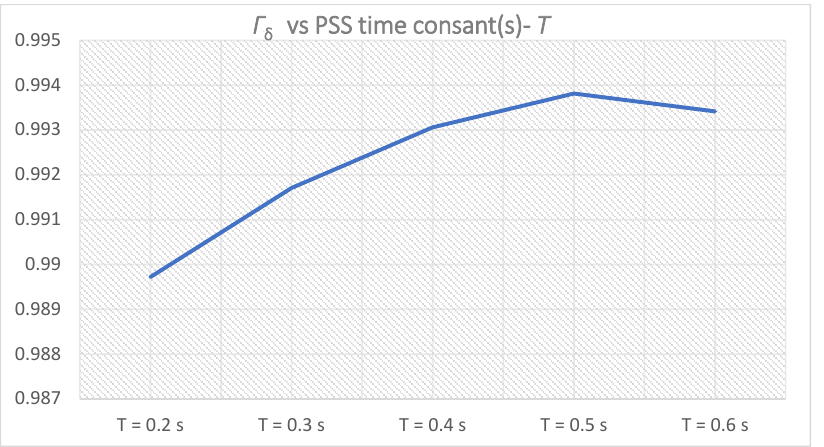
Energies 2021 , 14 , x FOR PEER REVIEW Figure 12. Γ δi for PSS parameters K = 10, T = Ti, 1 = 0.2 – 0.6 s. Figure 12. Γ δ i for PSS parameters K = 10, T = T i , 1 = 0.2–0.6 s. Figure 12. Γ δi for PSS parameters K = 10, T = Ti, 1 = 0.2 – 0.6 s.